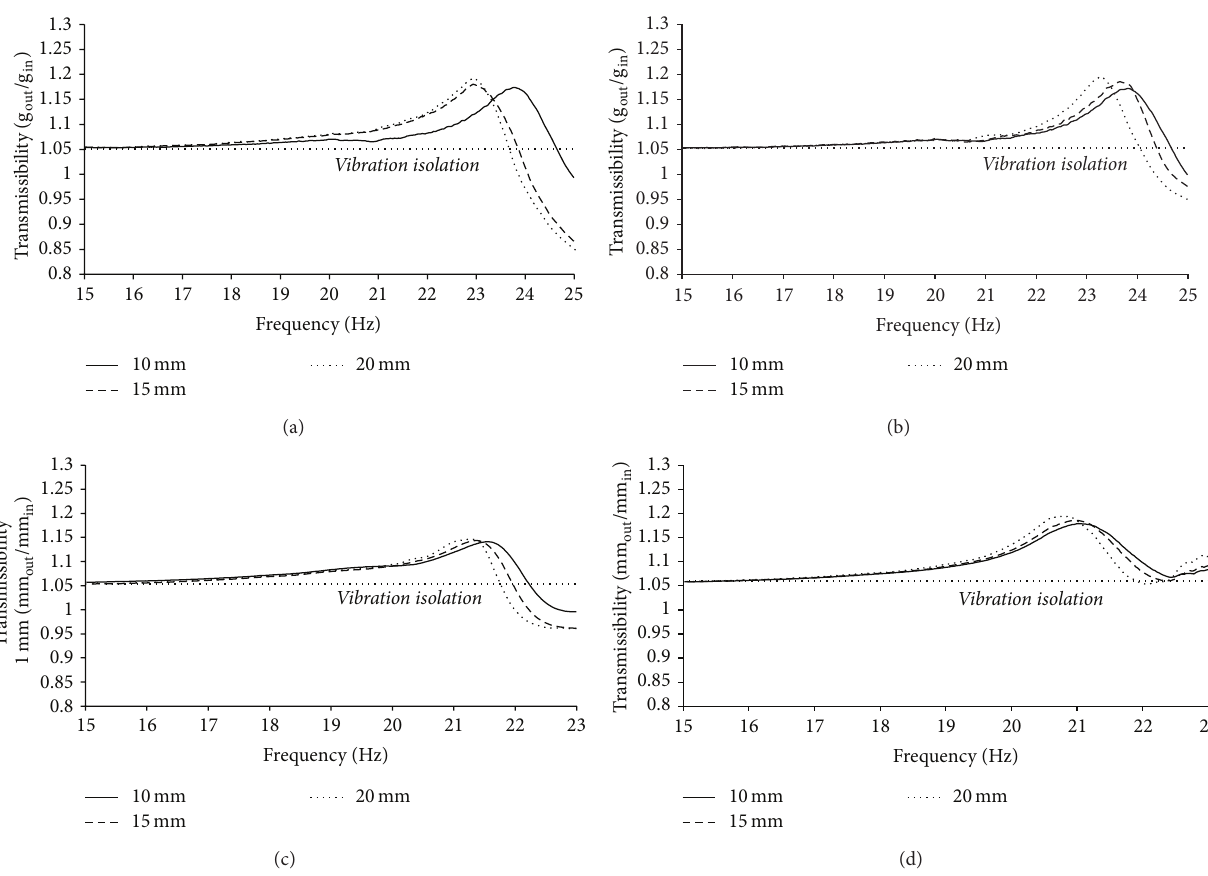
Figure 9: Transmissibility curve from base to moveable top plate: (a) 0.15 G and (b) 0.1G and (c) 1mm and (d) 1.5 mm base